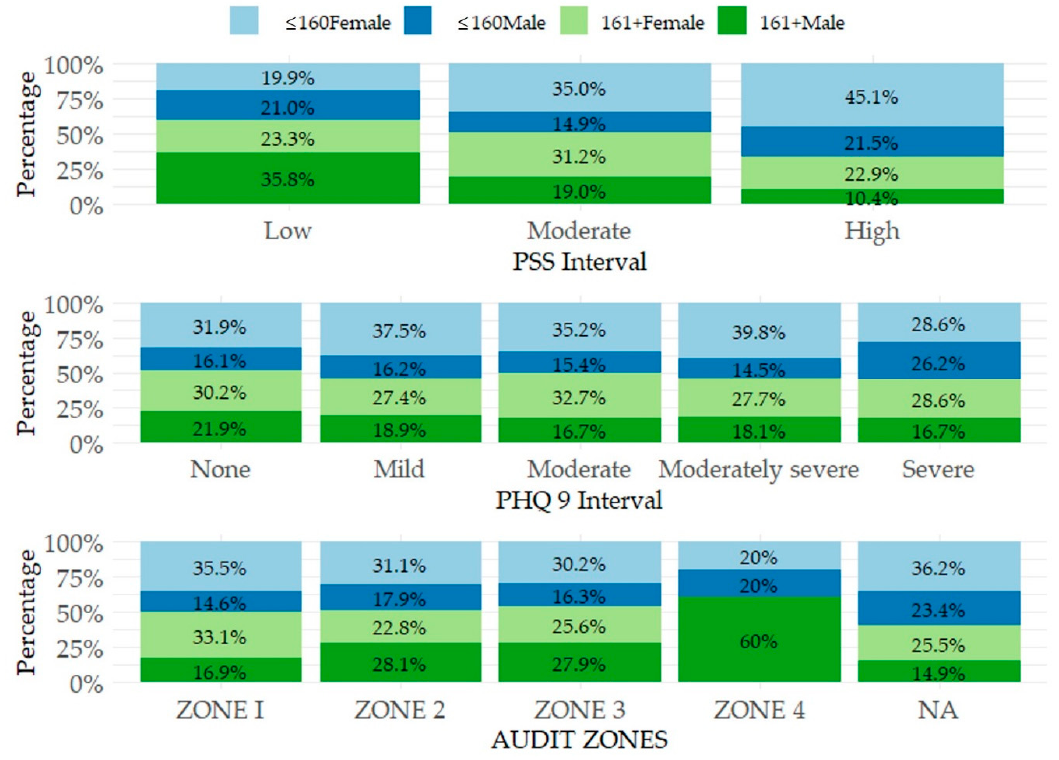
Figure 1. Distribution of PSS, PHQ 9, and AUDIT intervals in terms of gender-income categories.